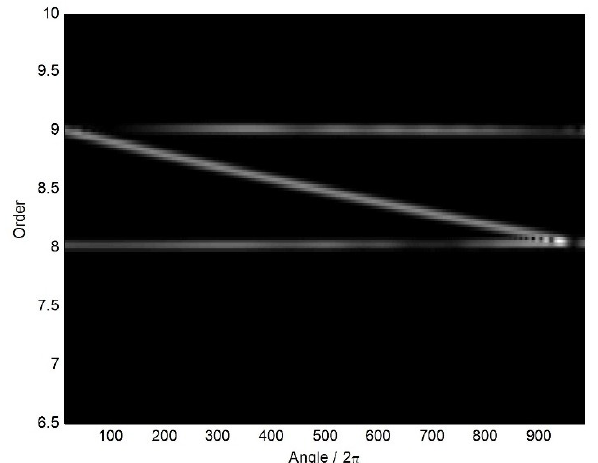
Figure 16. Time-varying order spectrum of the angular-domain reconstruction signal using two non-uniform BTT sensors under VRS.